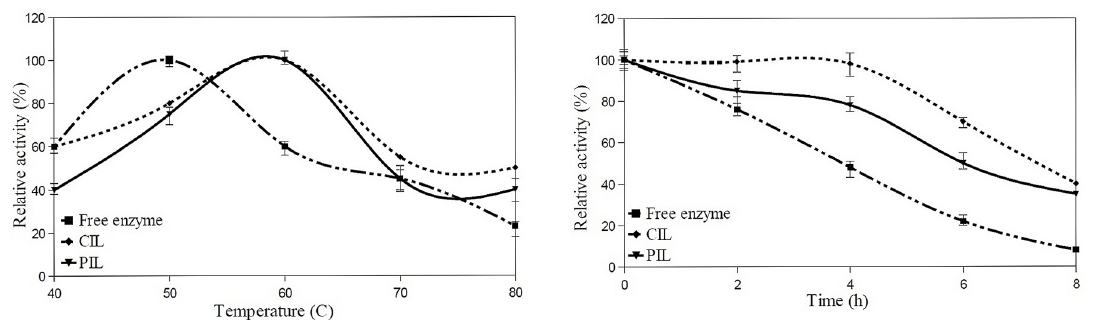
Figure 4: The effect of temperature on enzyme stability.